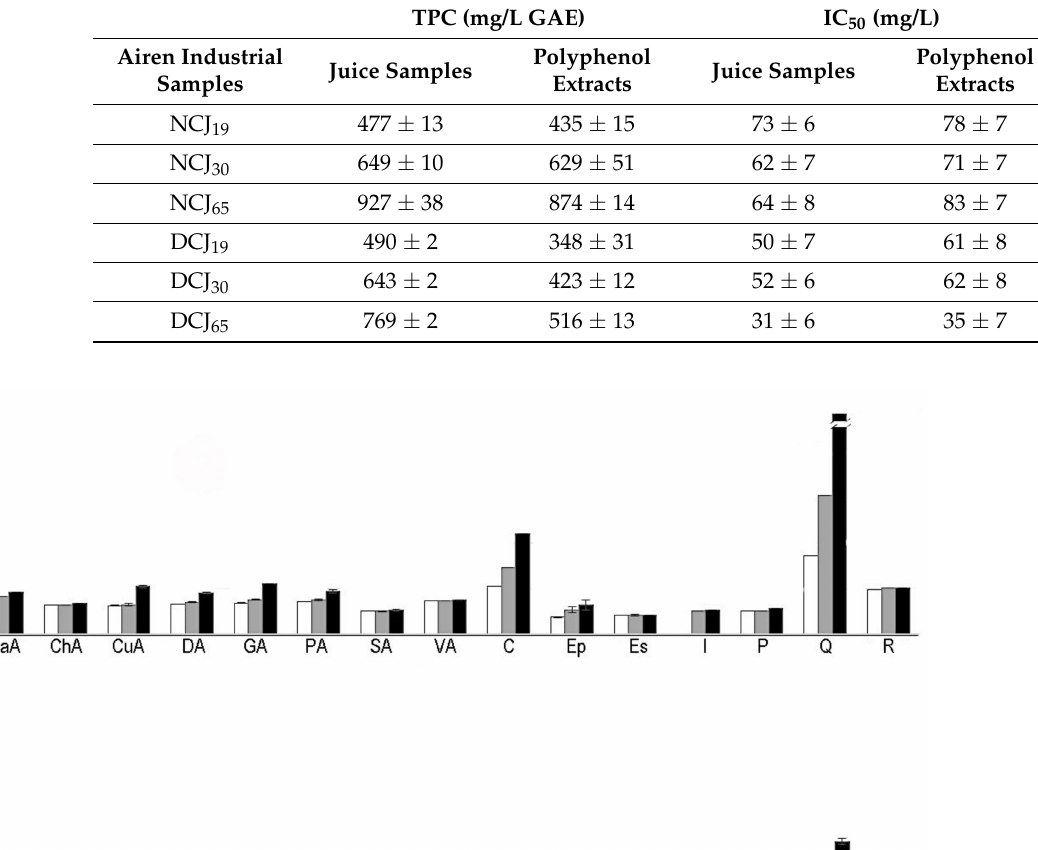
Table 4. Total polyphenol content (TPC, expressed in mg/L GAE ± standard deviation) and DPPH scavenging activity (IC 50 , expressed in mg/L ± standard deviation) of the industrial Airen samples and their extracts.